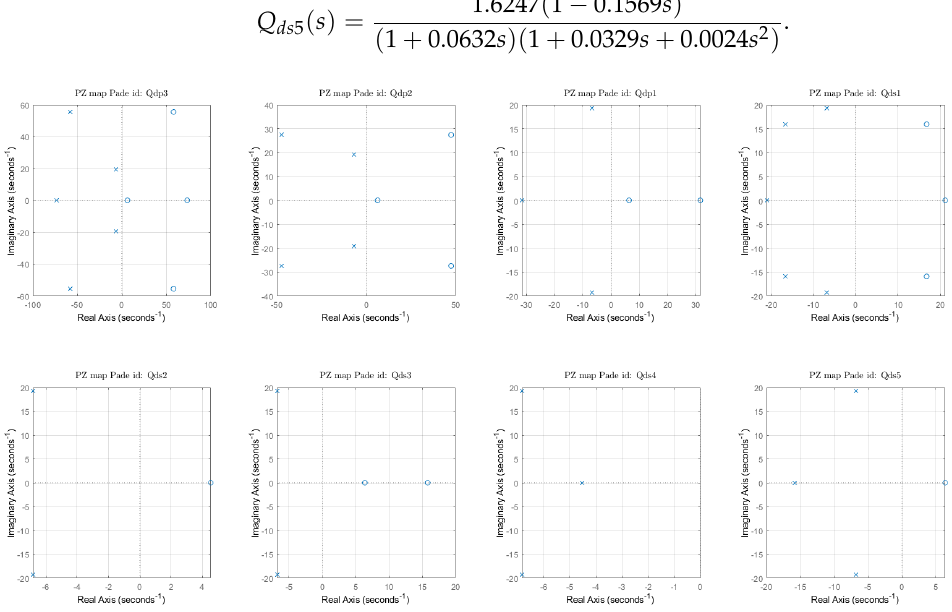
Figure 2. Pole–zero map of the various Q d (pitch rate) TF